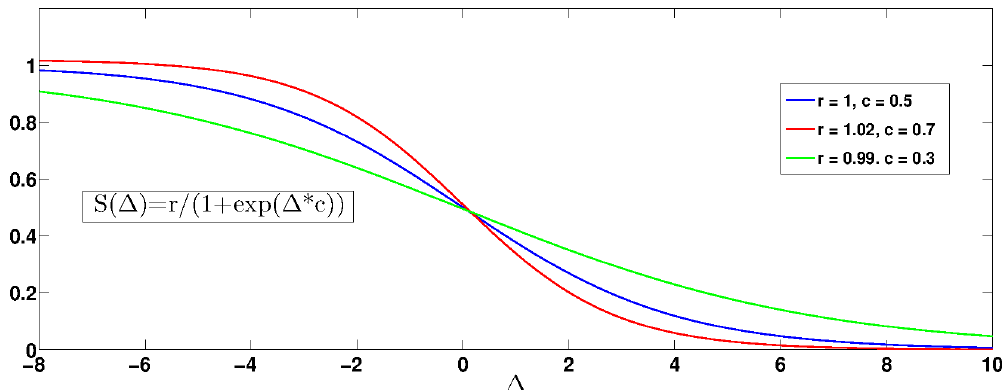
Figure 6. Modified sigmoid functions for intensity